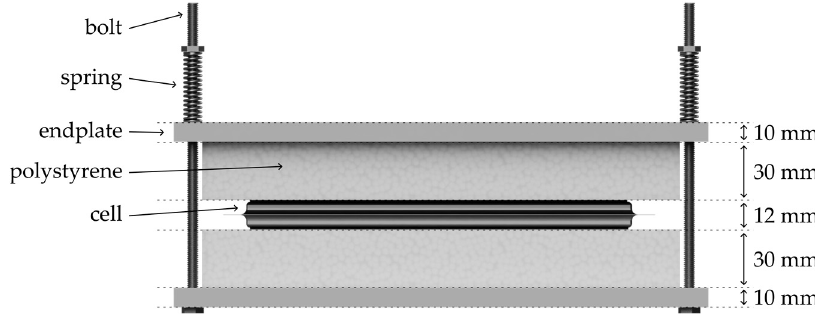
Figure 4. Depiction of test setup.